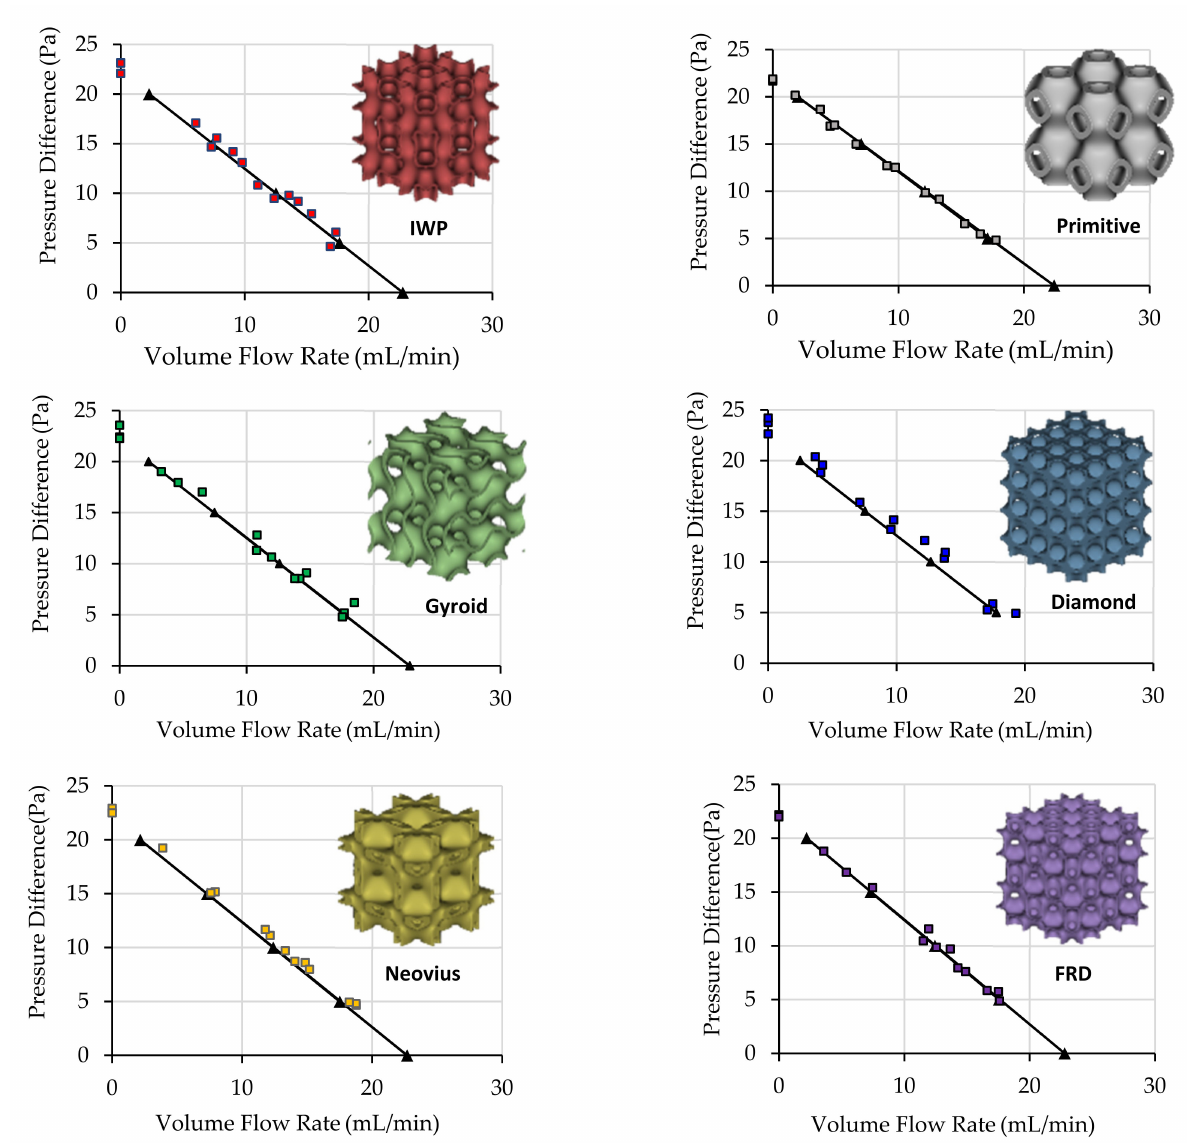
Figure 9. Performance curves from experimental results (rectangles) and simulation results (Triangles with a solid line) when different TPMS structures were placed on the inlet side of the